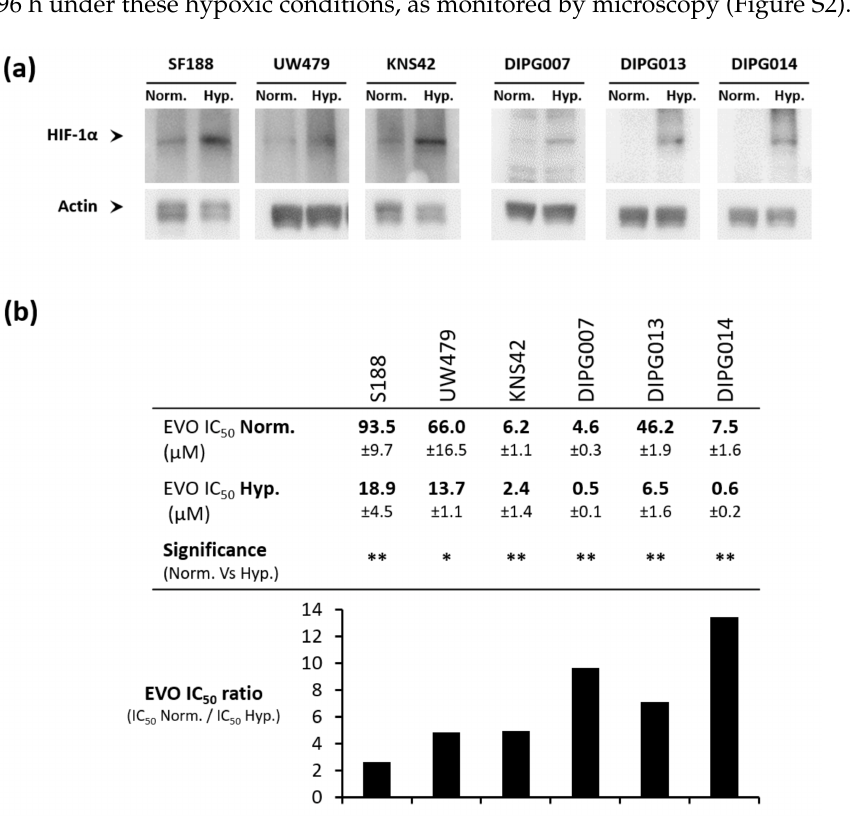
Figure 1. Hypoxic pediatric high-grade glioma (pHGG) and diffuse intrinsic pontine glioma (DIPG) cells are more sensitive to Evofosfamide (Evo) compared to normoxic ones. ( a ) Hypoxia inducible factor-1 α (HIF-1 α ) expression level assessed by Western blot in pHGG and DIPG cell lines incubated for 72 h under hypoxia 1% O2 (Hyp.) compared to normoxia (Norm.). ( b ) Determination of Evo IC 50 (inhibitory concentration 50) value after 72 h of treatment in pHGG and DIPG cell lines. IC 50 are compared for each cell line between the normoxic condition (Norm.) and hypoxic condition 1% O2 (Hyp.) to calculate an Evo IC 50 ratio. Values are the means of three independent experiments +/ − SD. ** p < 0.001; * p <